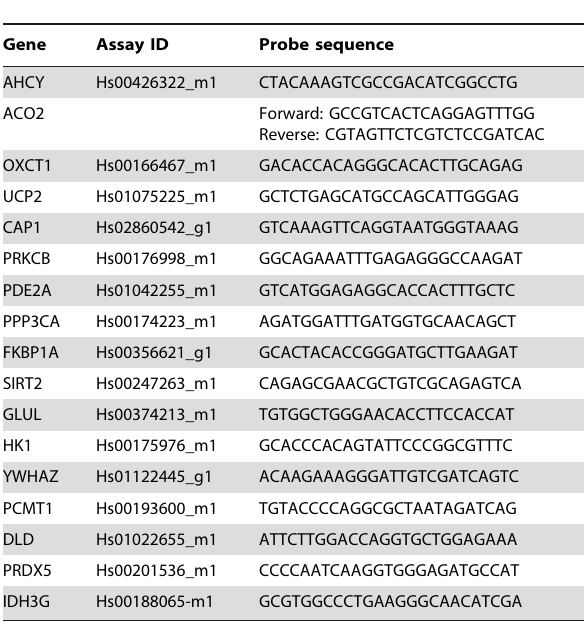
Table 3. Lists of assay ID and probe sequence for